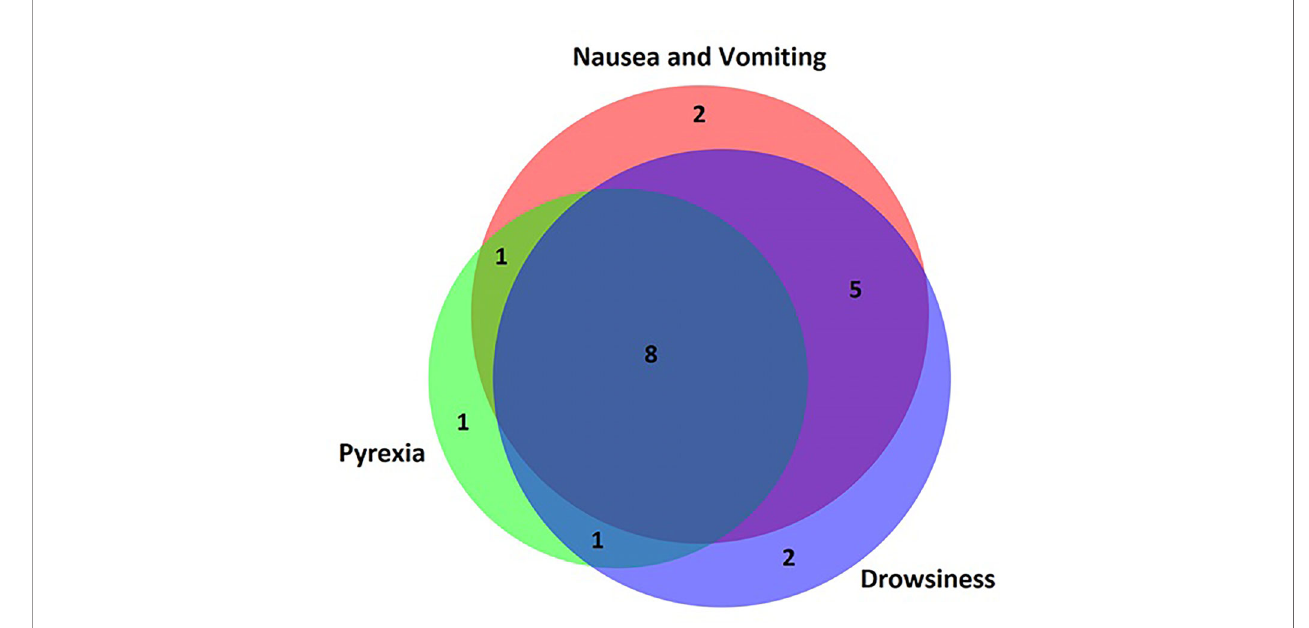
FIGURE 2 | Venn diagram of parent-reported symptoms. Most patients presented with overlapping symptoms and very few patients presented to hospital with an isolated symptom. Nausea/vomiting, pyrexia and drowsiness were the most common parent-reported